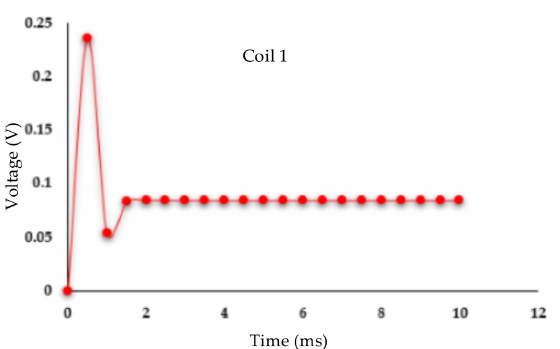
Figure 19. Transient response of voltage.